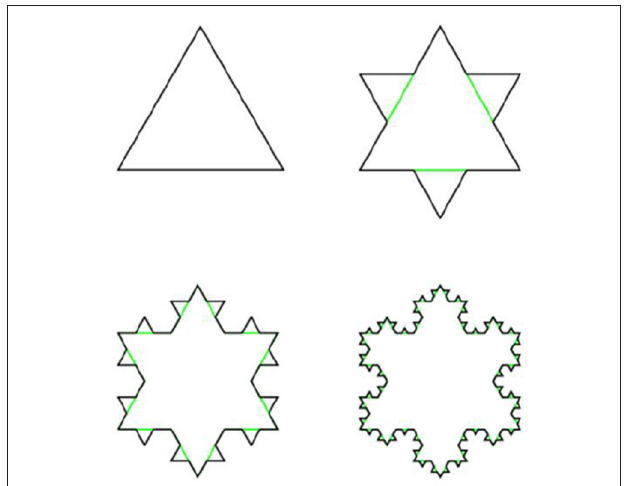
FIGURE 14 | Construction of Koch snowflake.